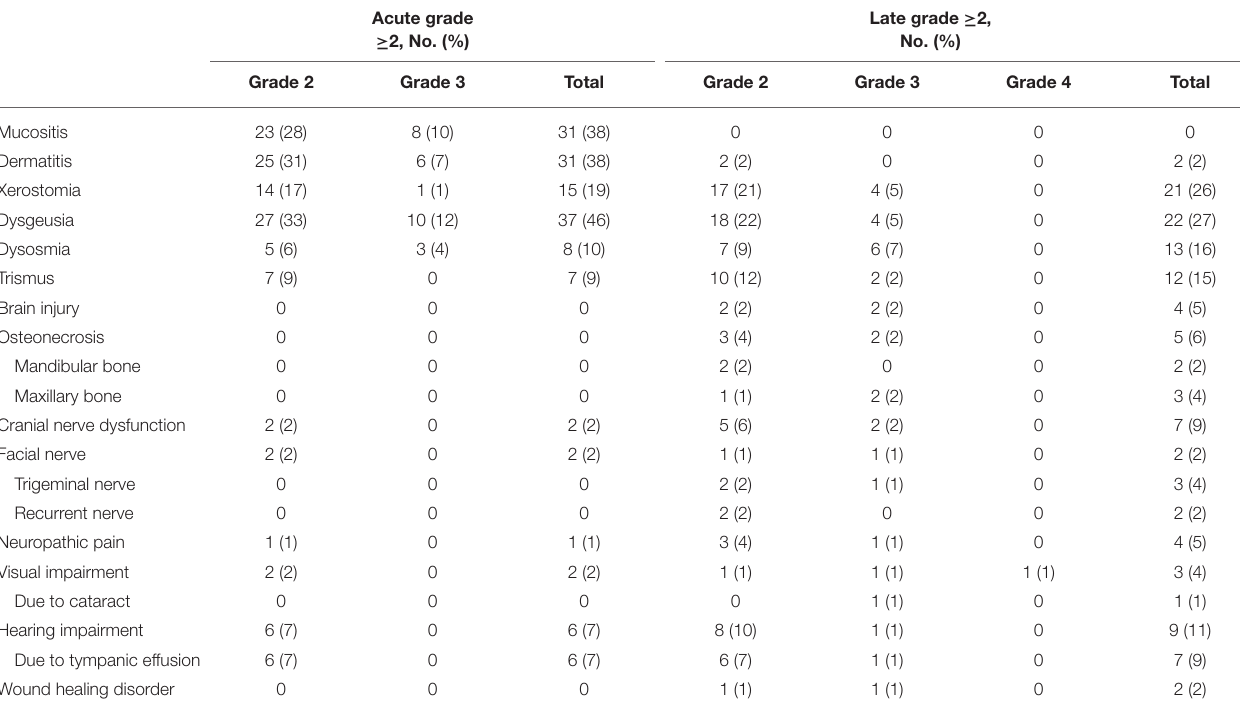
TABLE 4 | Acute and late adverse events (grade ≥